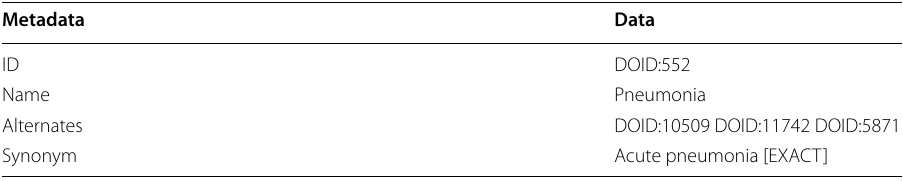
It has one main DOID and three alternates DOID. All of them refer to same disease